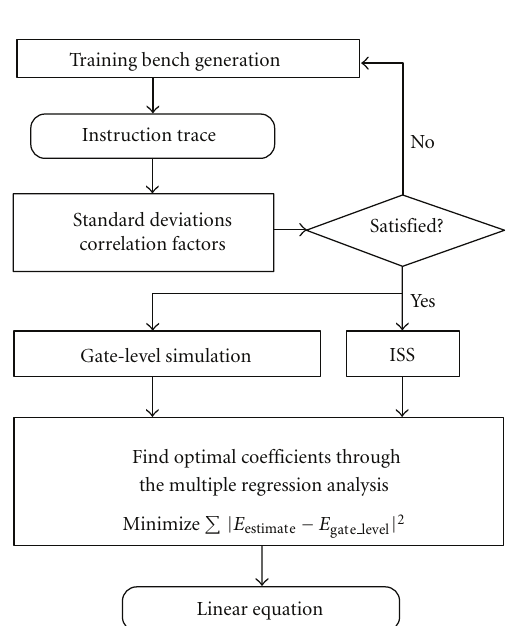
Figure 4: Impact of training bench selection.